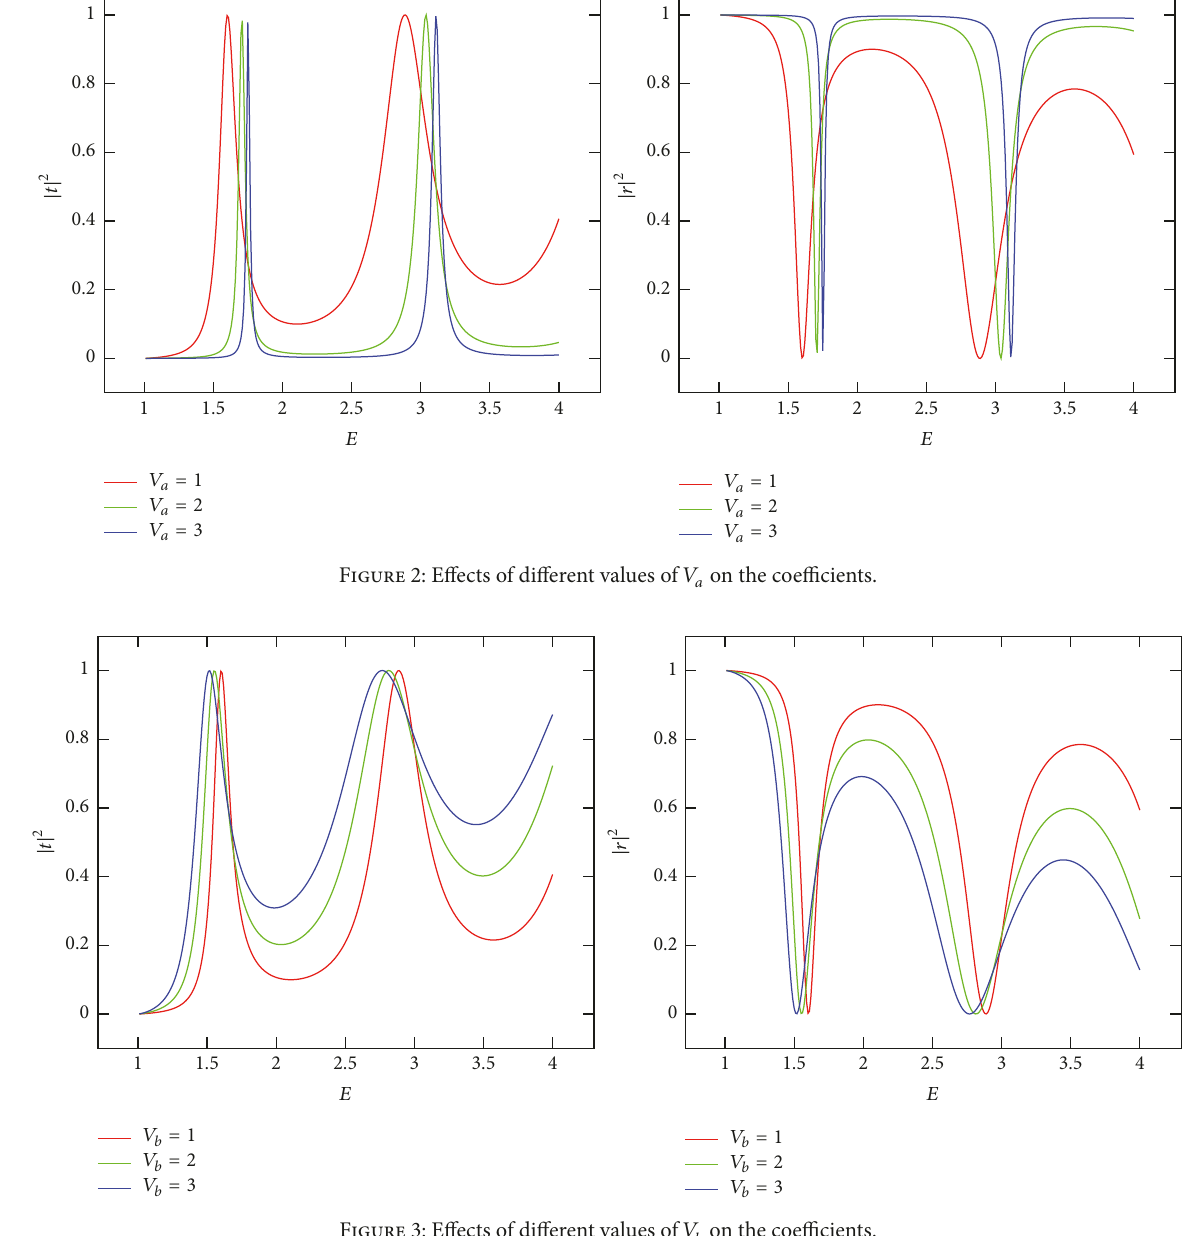
Figure 3: Effects of different values of 𝑉 푏 on the